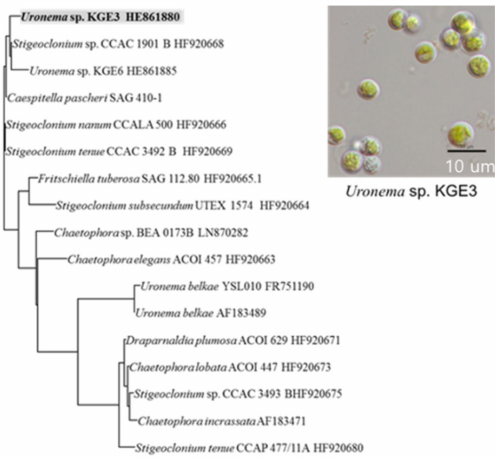
Figure 1. Uronema sp. KGE3 cell morphology and phylogenetic tree displays the connection between the NSU(Nuclear large subunit) rDNA D1-D2 sequences of the isolates Uronema sp. KGE3 and the maximum parallel sequences rescued from the NCBI nucleotide